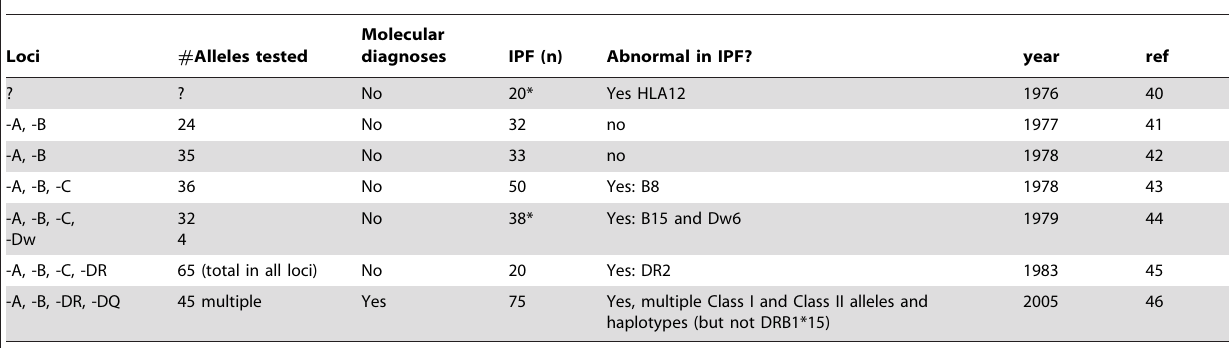
Table 4. Published studies of HLA allele frequencies in IPF.